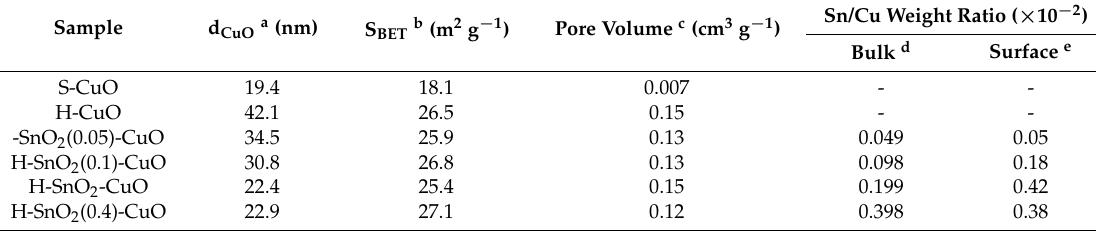
Figure 3. ( a – d ) FESEM images of H-SnO 2 -CuO; and ( e ) EDS mapping images: Cu (red), O (green) and Sn (yellow). The insert in image e is the corresponding EDS pattern. Table 1. The physical property of all the